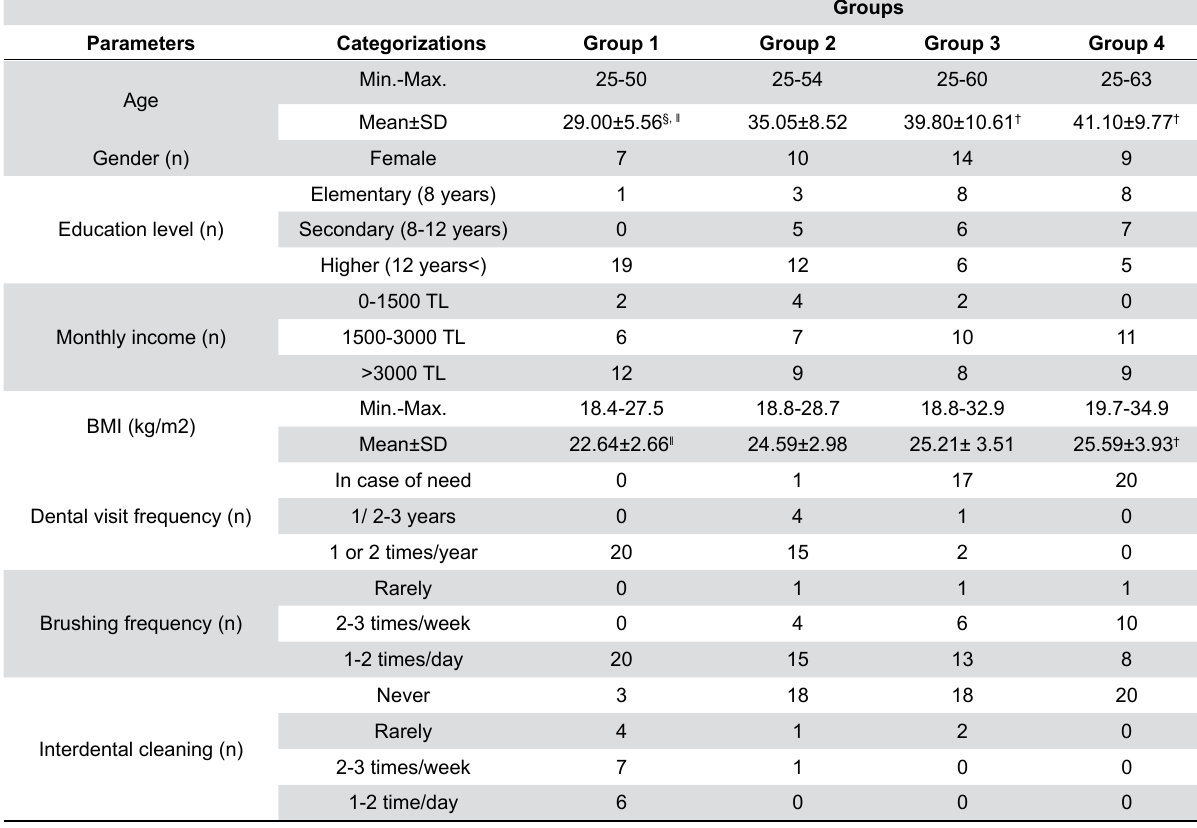
Table 1- Sociodemographic parameters and characteristics of the study